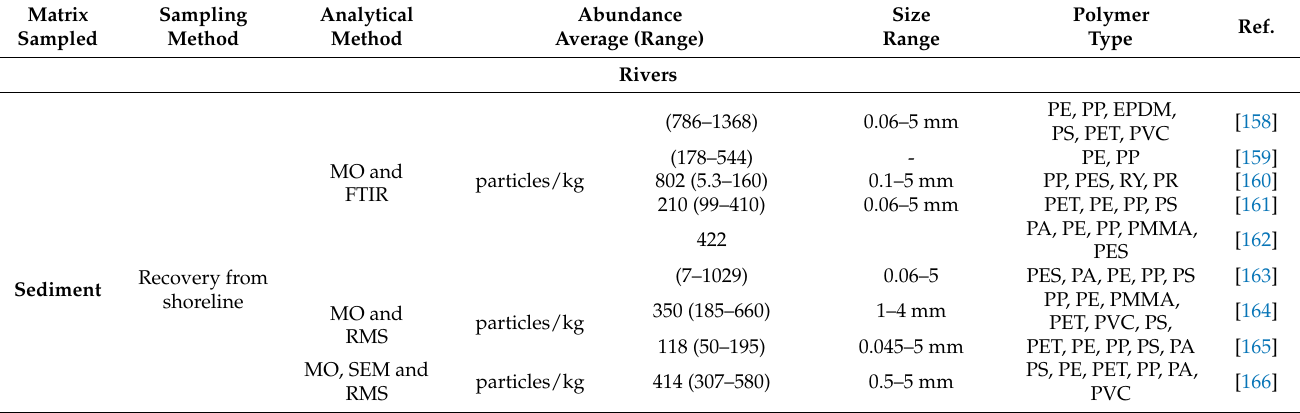
Table 2. Microplastics abundance in freshwater and